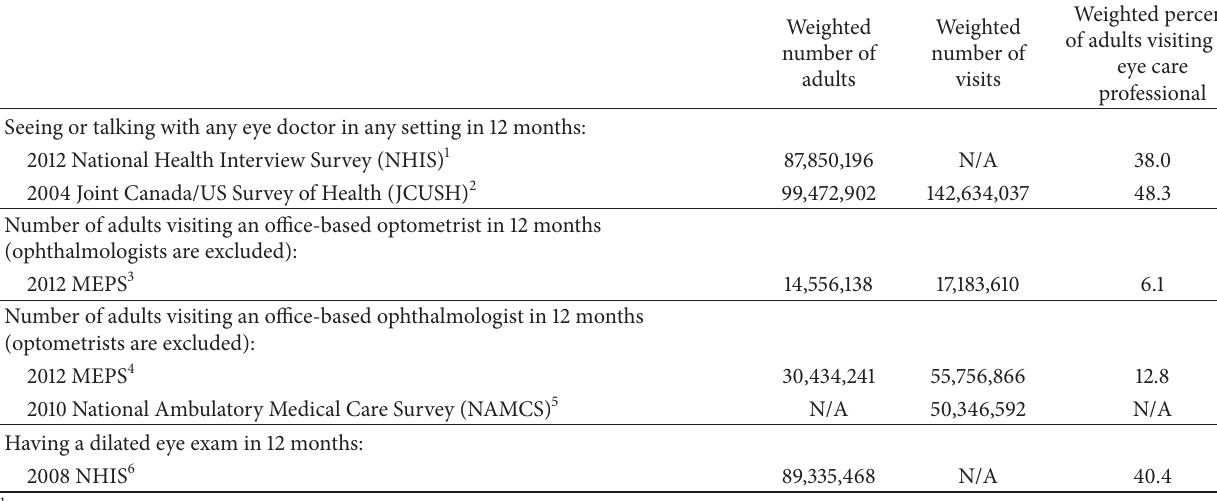
Table 1: Weighted number and percentage of adults aged 18 and older utilizing eye care services and weighted number of eye care visits in the United States stratified by nationally representative database.